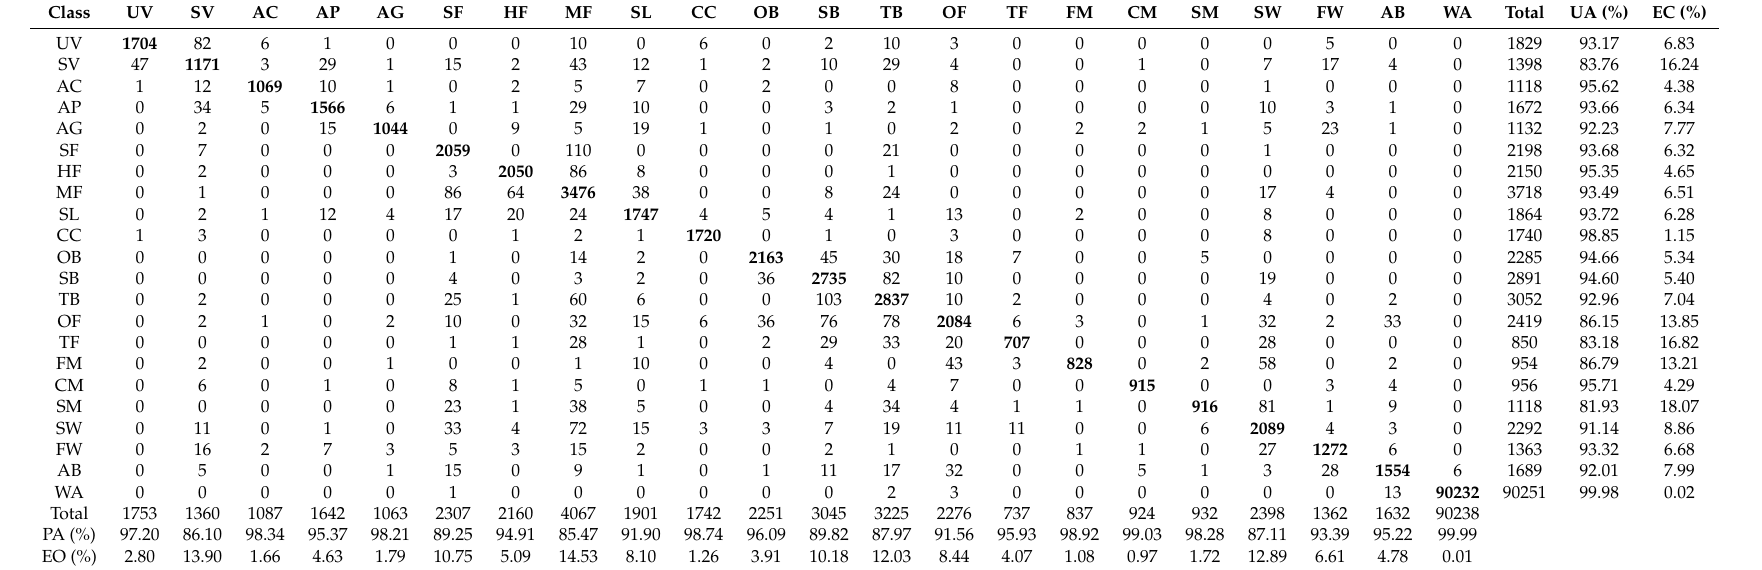
Table 9. Confusion matrix (in pixels) and associated accuracies when the RF classifier is applied to all the images and the Lidar-derived